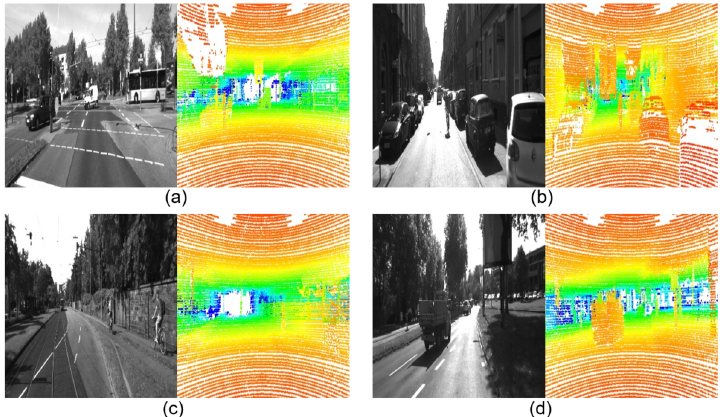
Figure 1. Camera images (left image in ( a – d )) and LiDAR depth maps generated from LiDAR raw data (right image in ( a – d )).